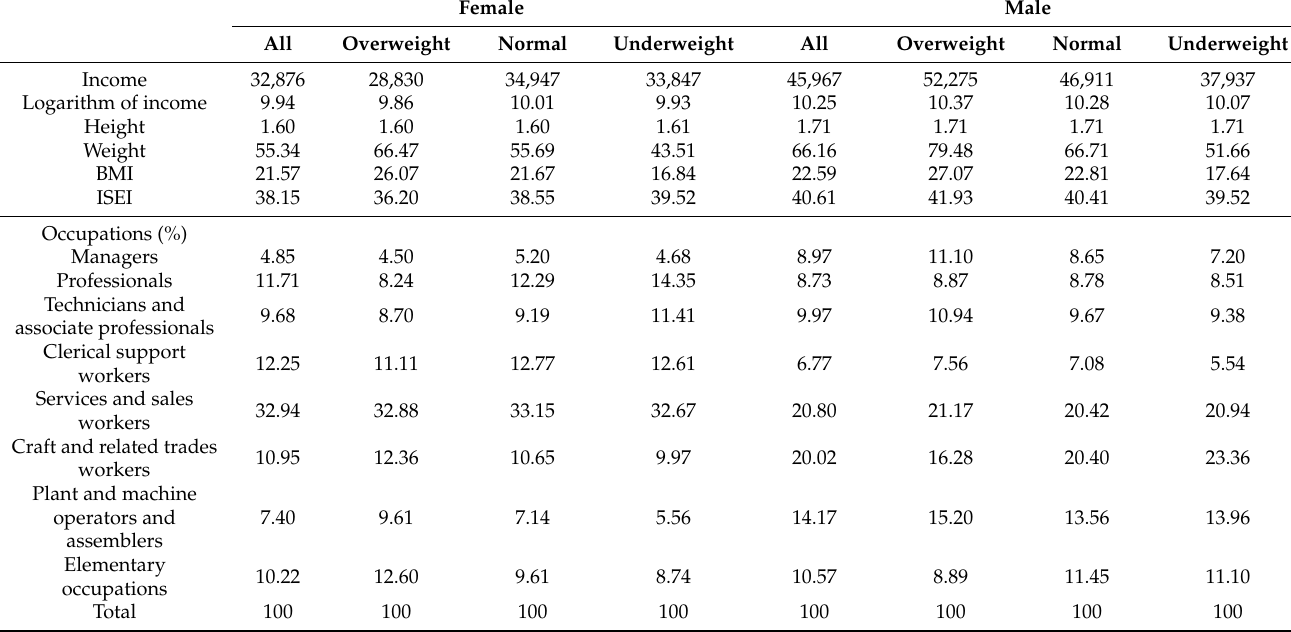
Table 2. Mean of key variables and occupational